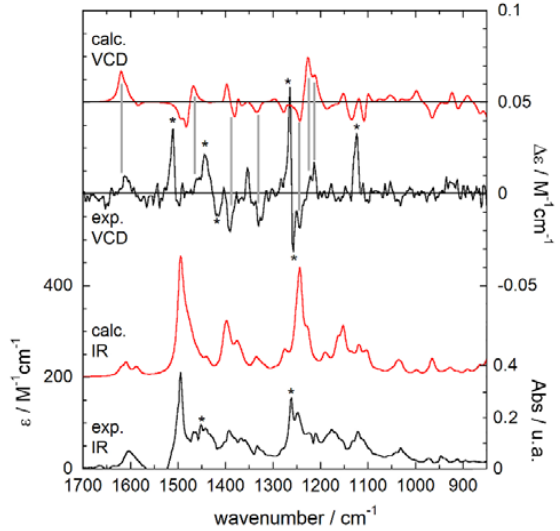
Figure 6. Experimental (black lines) and calculated (red lines) IR (bottom traces) and VCD (top traces) spectra of ( R )- 1 . Experimental conditions: 0.18 M solution in CCl 4 , cell path length 100 µ m. Calculations run at B3LYP/6-311+G(d,p) level, Boltzmann average over 40 conformers, plotted as sum of Lorentzians with γ = 6 cm − 1 , scaling factor 0.98. The vertical bands highlight the correspondence between experimental and calculated VCD peaks, while the asterisks (*) indicate experimental IR/VCD peaks with no calculated counterpart.